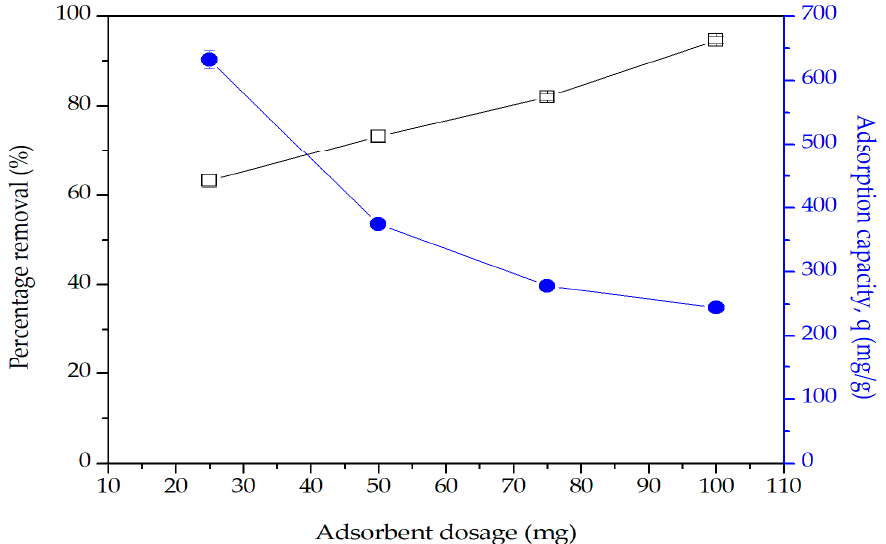
Figure 11. E ff ect of adsorbent dosage on the percentage removal and adsorption capacity, q. Condition: [Pb(II)] = 100 mg / L, pH = 5, contact time = 120